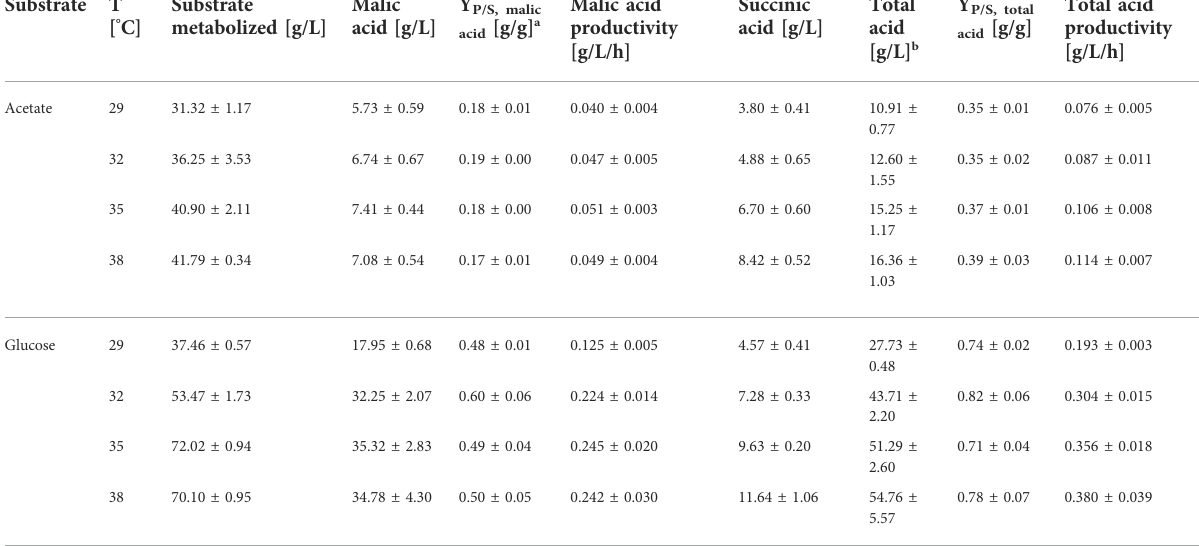
TABLE 1 Fermentation results for cultivations of A. oryzae at different temperatures after 144 h. Values are means ± standard deviation, n = 4. Substrate T [ ° C]